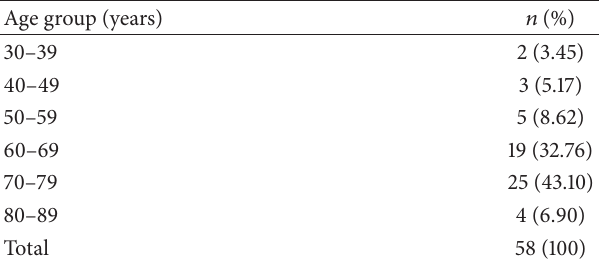
Table 1: Distribution of age.